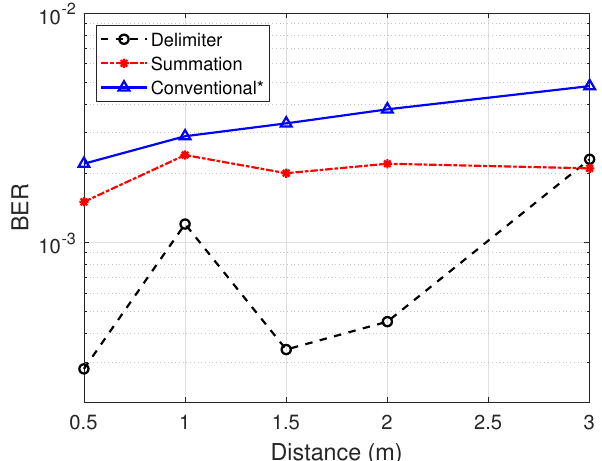
Figure 12. Bit-error-rate comparison with good environmental conditions in the office